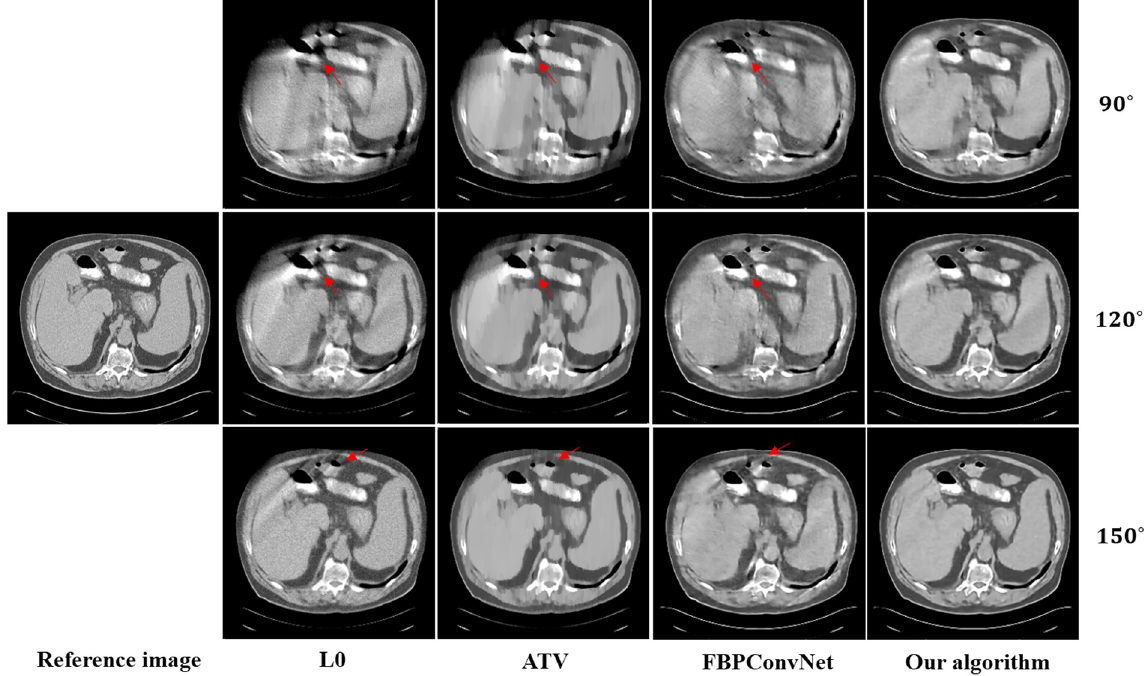
Fig 10. The reconstructed results of the abdomen image from the noise-add experiment. The image on the first column is the reference image. The subsequent columns are the results reconstructed using L0 method, ATV method, FBPConvNet method and our algorithm. The images from top to bottom in each row are the results reconstructed for the scan ranges [0˚, 90˚], [0˚, 120˚] and [0˚, 150˚], respectively. The location of red arrows present some obvious artifacts, and the display window is [800 1200]